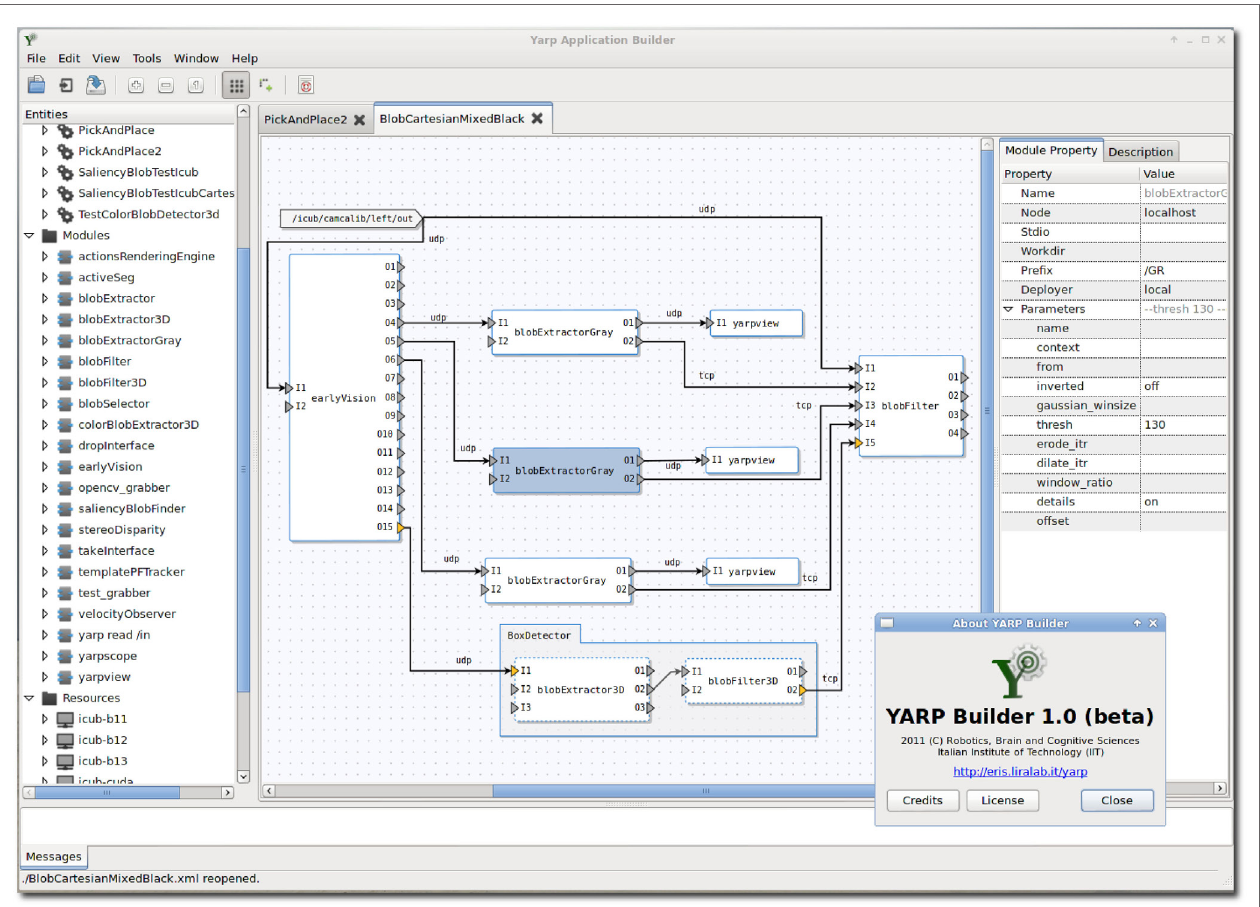
FigUre 10 | a screenshot of yarpbuilder . The GUI allows to build applications by dragging and dropping components and by wiring the connections. The applications designed in the yarpbuilder can be executed by the yarpmanager